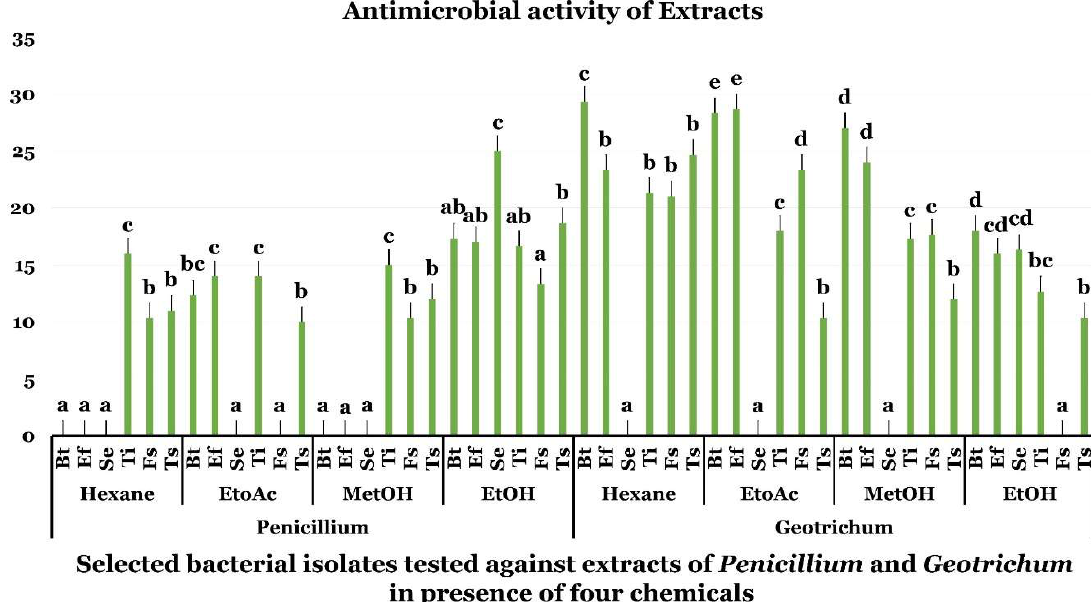
Figure 2. Antimicrobial activity of extracts of Geotrichum and Penicillium against bacterial and fungal species in the presence of hexane, EtOAc, MetOH, EtOH. Data presents mean ± standard error. Bars labelled with different letters are significantly different among the treatments at p < 0.05 using the Tukey’s HSD test. In each bar groups, bars labelled with the same letter are not significantly different from each other according to Tukey’s HSD at p < 0.05.